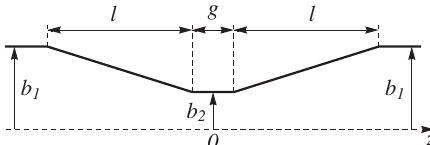
FIG. 1. Geometry of an axisymmetric